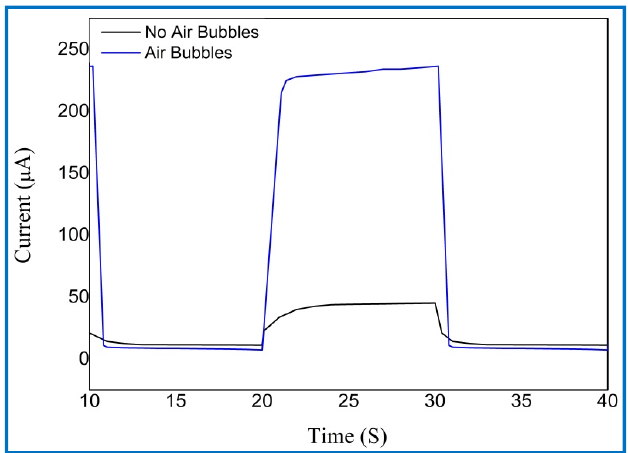
Figure 20. The magnified (on/off) photoresponse cycle for the fabricated UV photodetectors based on ZnO nanorods grown with no air bubbles, with oxygen bubbles, and with air bubbles.